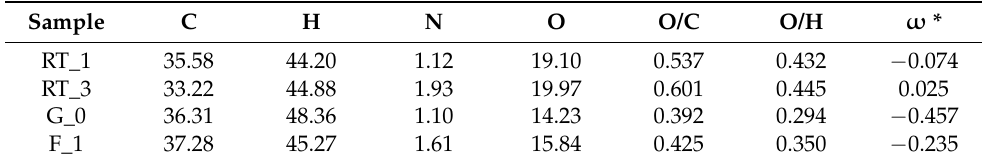
Table 1. Elemental composition of the humic acids (in atomic percentage).